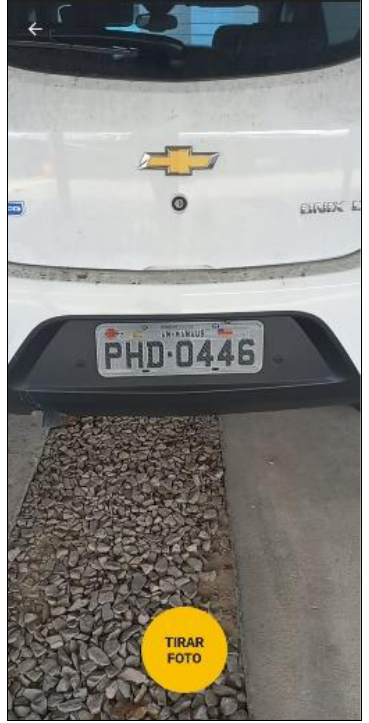
Figure 11: Car Plate Image Capture Screen.